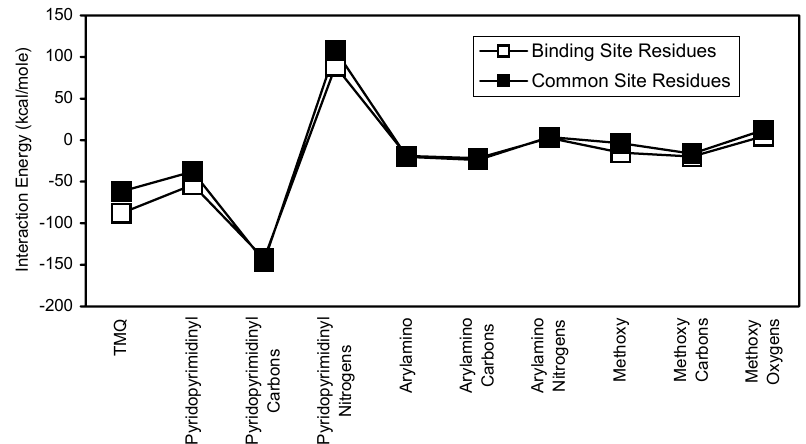
Figure 16 . Comparison of binding site and common site interaction with TMQ and its substructural